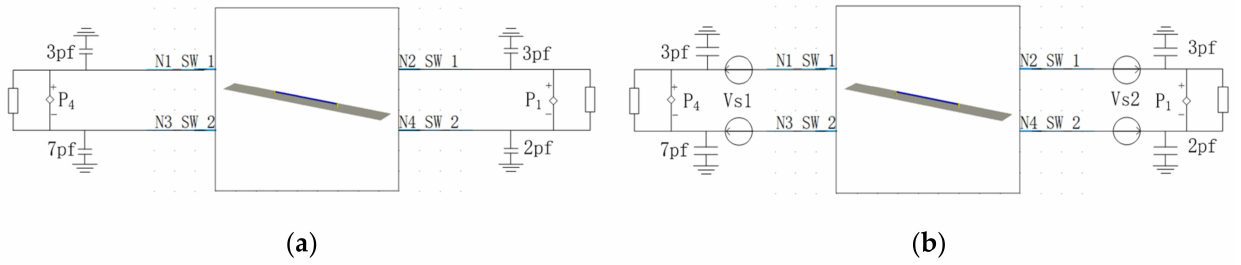
Figure 6. Simulation model: ( a ) radiation model; ( b ) injection